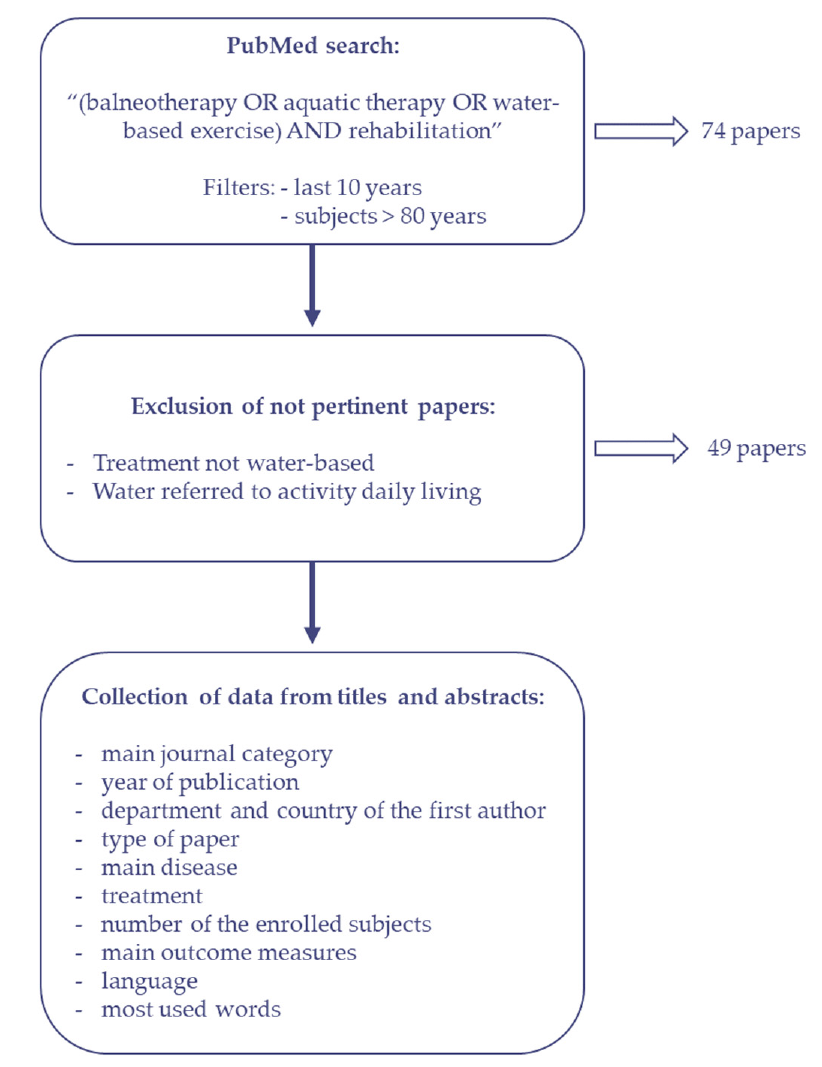
Figure 2. Flow-chart of the literature analysis and paper selection.